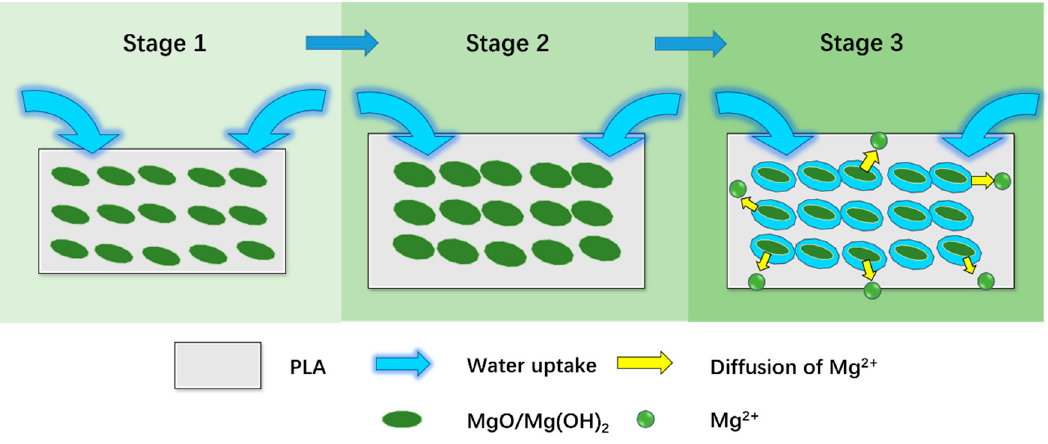
Figure 13. Schematic representation of the degradation of MgO/PLA composite scaffolds. Changes of the surface morphology after degradation were rather insignificant, with the only exception being the PGF/PLA composite, upon which the globular precipitates